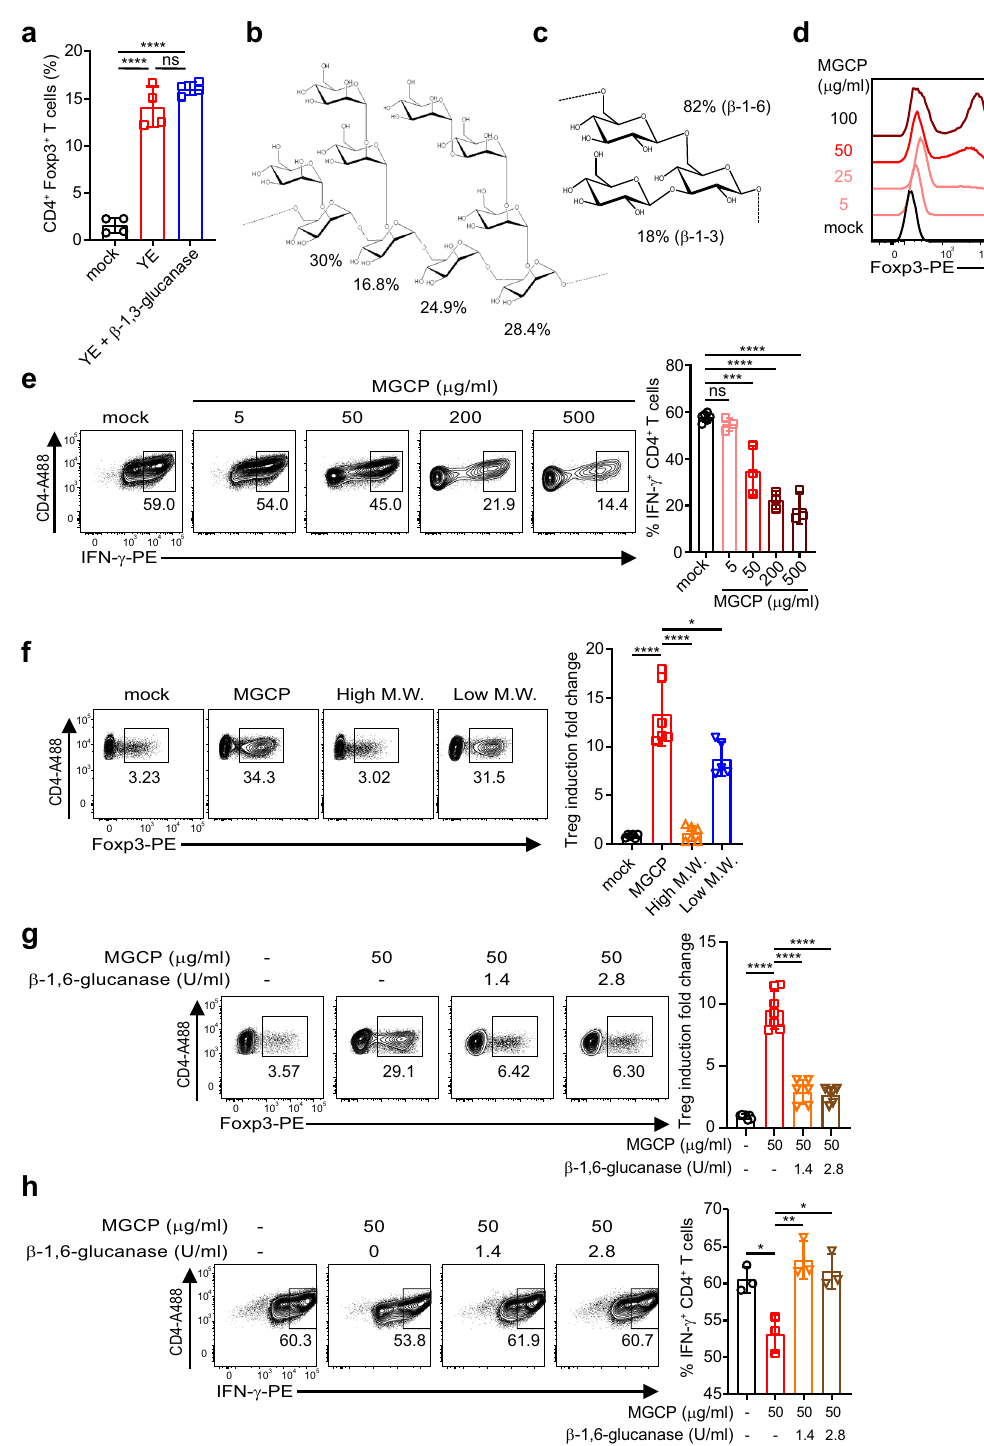
Fig. 2 Yeast cell wall-derived MGCP facilitates Treg cell induction and represses Th1 differentiation. a Yeast extract (YE) was puri fi ed from intact or β - 1,3-glucan removed yeast cells. Splenic CD11c + DCs treated with these YE were cultured with naive CD4 + T cells in the presence of minimal amount of Treg-inducing cytokines. Frequency of Treg cells is shown. Each dot represents an individual sample. Data are analyzed with pooled data of 2 independent experiments. b , c Structural analyses of MGCP through nuclear magnetic resonance (NMR). Chemical structure of mannan ( b ) and β -1,6-glucan moiety of MGCP ( c ). d – h Splenic CD11c + DCs were subjected to MGCP ( d , e ), individual MGCP fractions ( f ) or enzymatic treatment as indicated ( g , h ), followed by culture with naive CD4 + T cells. Representative fl ow cytometric plots (left) and frequency (right) of Treg cells in the presence of suboptimal Treg-inducing condition ( d , f , g ) and Th1 cells under suboptimal Th1 skewing condition ( e , h ) are shown. Each dot represents an individual sample. Results are analyzed from pooled data of 3 independent experiments ( d , f ) or 2 independent experiments ( g ) and 2 independent experiments presented with representative data ( e , h ). All graph plots show the mean ± SD. * p < 0.05, ** p < 0.01, *** p < 0.001, **** p < 0.0001 (two-tailed student ’ s t test). ns: not signi fi cant. Source data are provided as a Source data fi